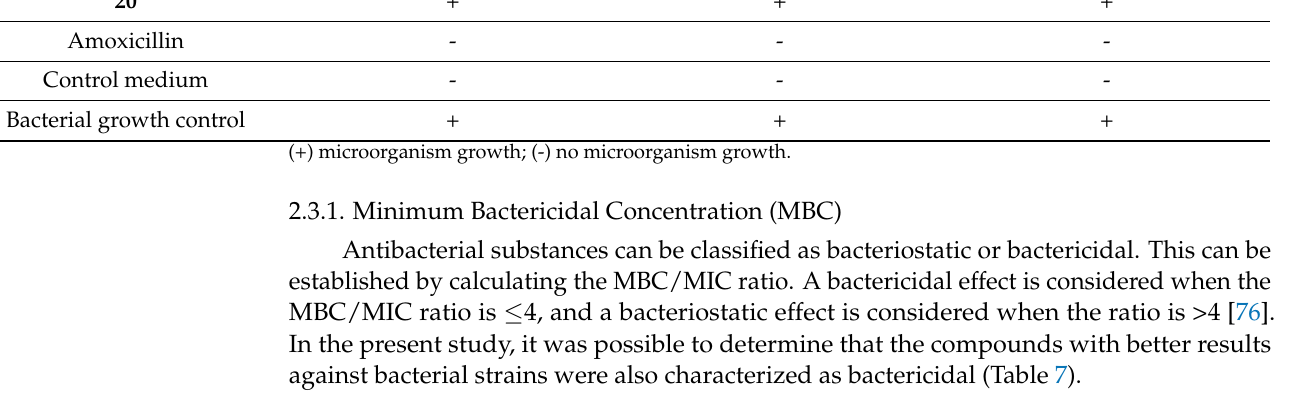
Table 7. Minimum inhibitory concentration (MIC) and minimum bactericidal concentration (MBC) of compounds 6 , 9 , and 18 .